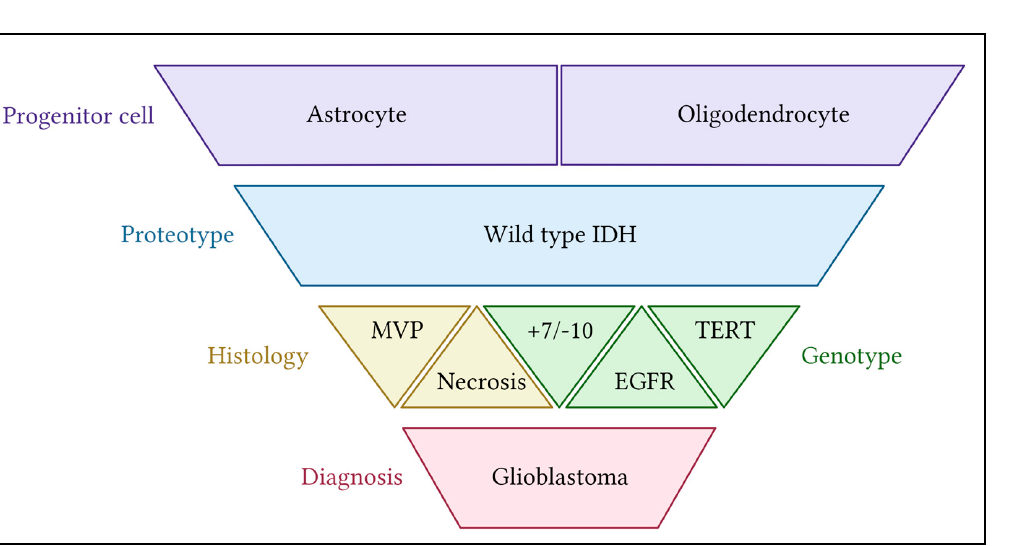
Figure 1. Shown are the 2021 WHO classification criteria for glioblastoma. In order of increasing specificity (top to bottom): (1) Biopsy assessment begins with the identification of the glial progenitor cell line. (2) Cells with mutant IDH are excluded. (3) Tumors with necrosis or MVP on histology are grade 4 and diagnosed as glioblastoma. Three mutations are also included in the GBM diagnosis, regardless of histology: the addition of a whole chromosome 7 in the absence of chromosome 10, TERT activation or EFGR gain of function [9].